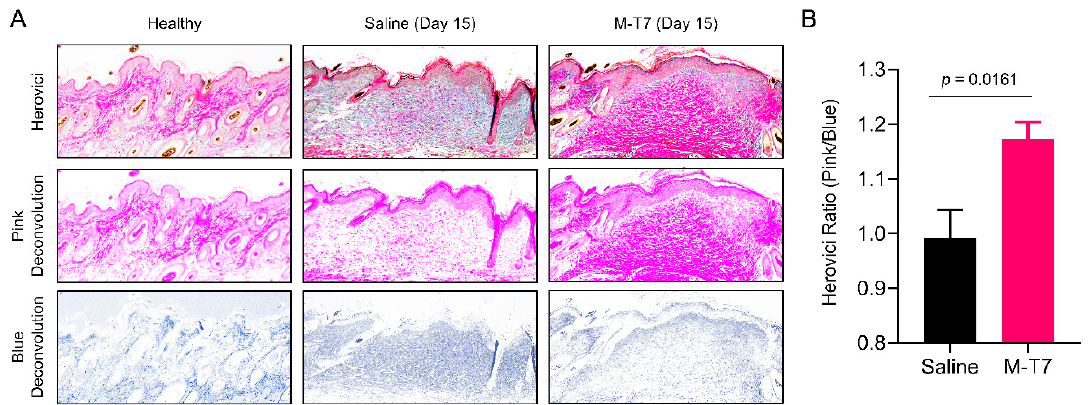
Figure 2. Quantitative assessment of collagen maturation in wounds treated with M-T7. ( A ) Representative micrographs of Herovici’s polychrome-stained normal skin and wounds at 15 days post-wounding. Top panels show brightfield data, while middle and bottom panels show color-deconvoluted fields for the pink and blue chromophores. ( B ) Quantification of collagen maturation in saline and M-T7 treated wounds by the Herovici Ratio, calculated by the densitometric ratio of the pink and blue chromophores in Herovici’s polychrome. Mean and standard error are shown. Statistics were calculated by T -test. N = 4 saline, N = 5 M-T7.